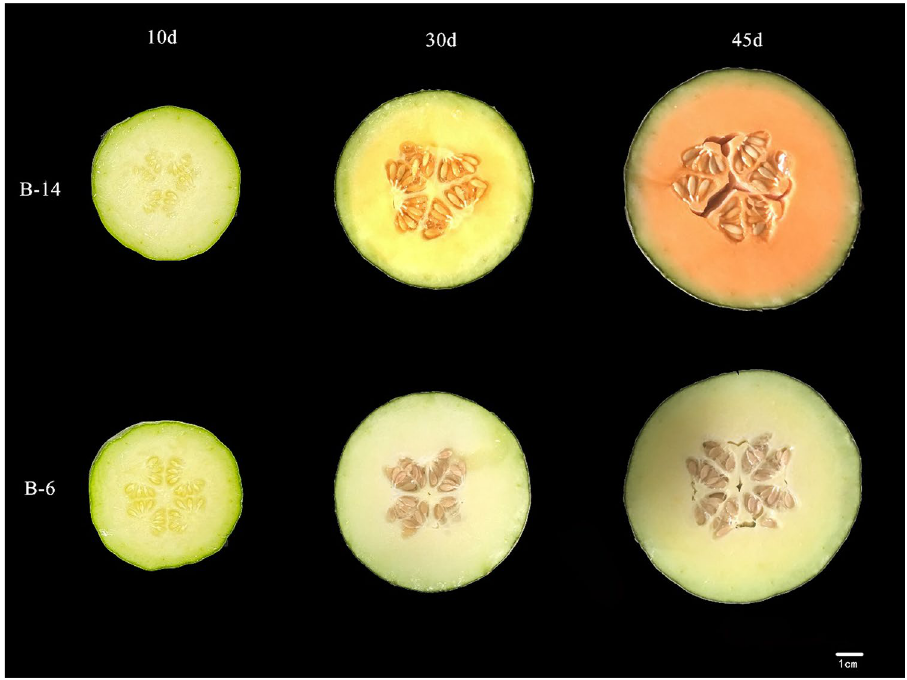
Figure 1. The flesh color of the two melon genotypes (“B-6” and “B-14”) at 10, 30, and 45 d after pollination (DAP). Scale bars = 1